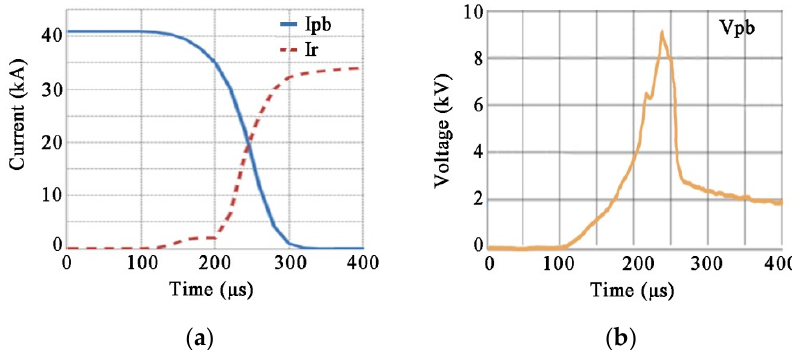
Figure 5. Commutation test at 40 kA: ( a ) Current oscillogram, ( b ) Voltage oscillogram.